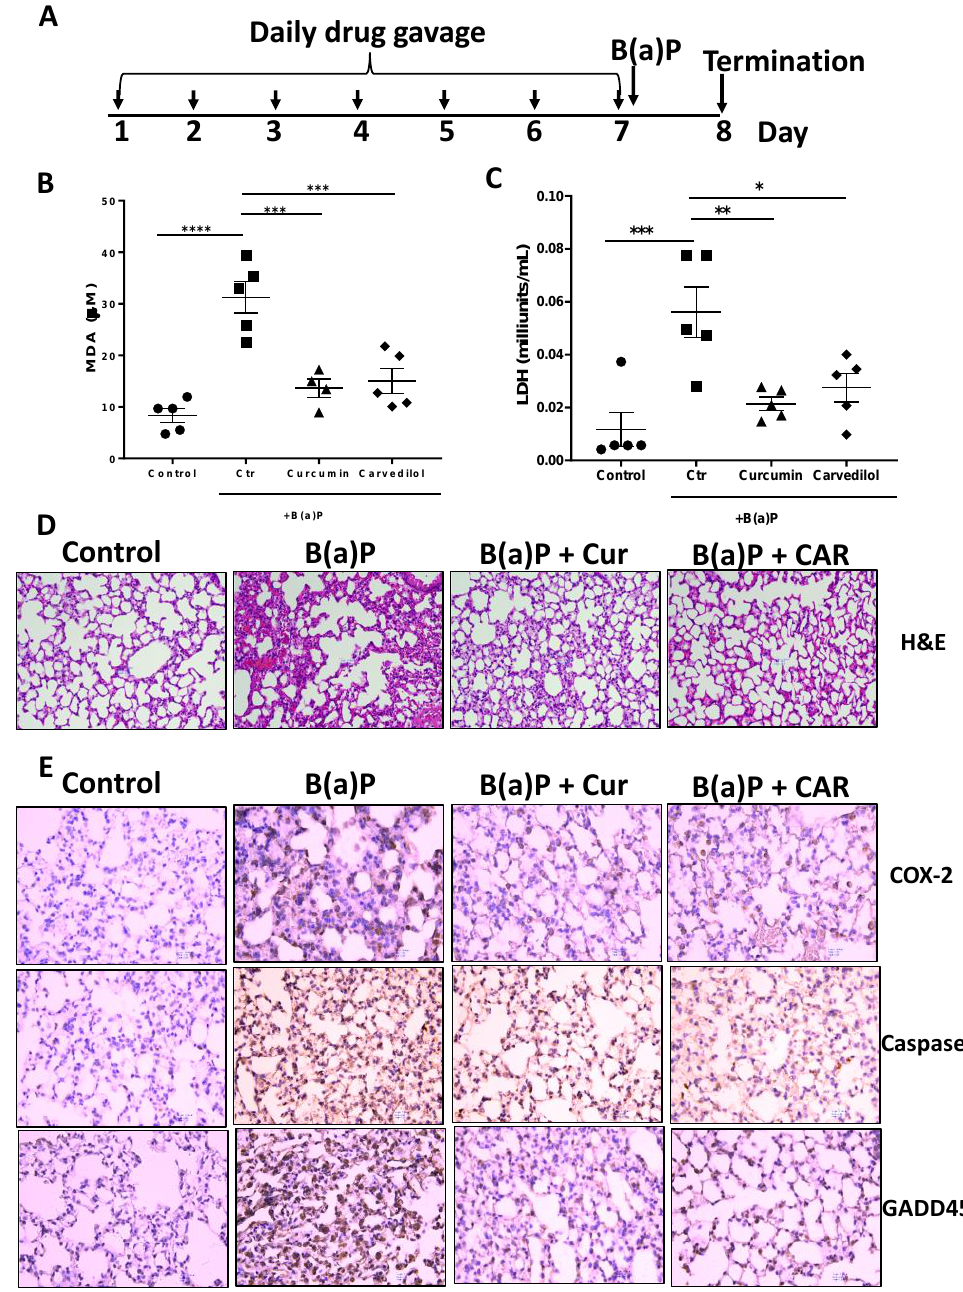
Figure 3. Effects of carvedilol on B(a)P-induced lung toxicity. ( A ) Experimental design. The CD-1/IGS mice were pretreated with carvedilol (20 mg/kg/day) or curcumin (100 mg/kg/day) by oral gavage for 7 days before B(a)P exposure. The mice were euthanized 24 h after B(a)P exposure. ( B ) Effects of carvedilol and curcumin on B(a)P-induced plasma levels of malondialdehyde (MDA), a marker to assess lipid peroxidation (LPO). ( C ) Effects of carvedilol and curcumin on B(a)P-induced plasma levels of lactate dehydrogenase (LDH), a marker for tissue damage. ( D ) Effects of carvedilol on B(a)P-induced histopathologic changes. H&E staining of mouse lung sections of the lung ( × 20). Scale bar: 100 µ m. ( E ) IHC analysis for expression of COX-2, caspase-3 and GADD45 α ( × 20). Scale bars: 100 µ m. Data plotted are mean + SD. An ordinary one-way ANOVA followed by Dunnett’s multiple comparison test was used to assess statistical differences. *: p < 0.05, **: p < 0.01, ***: p < 0.001, ****: p < 0.0001.